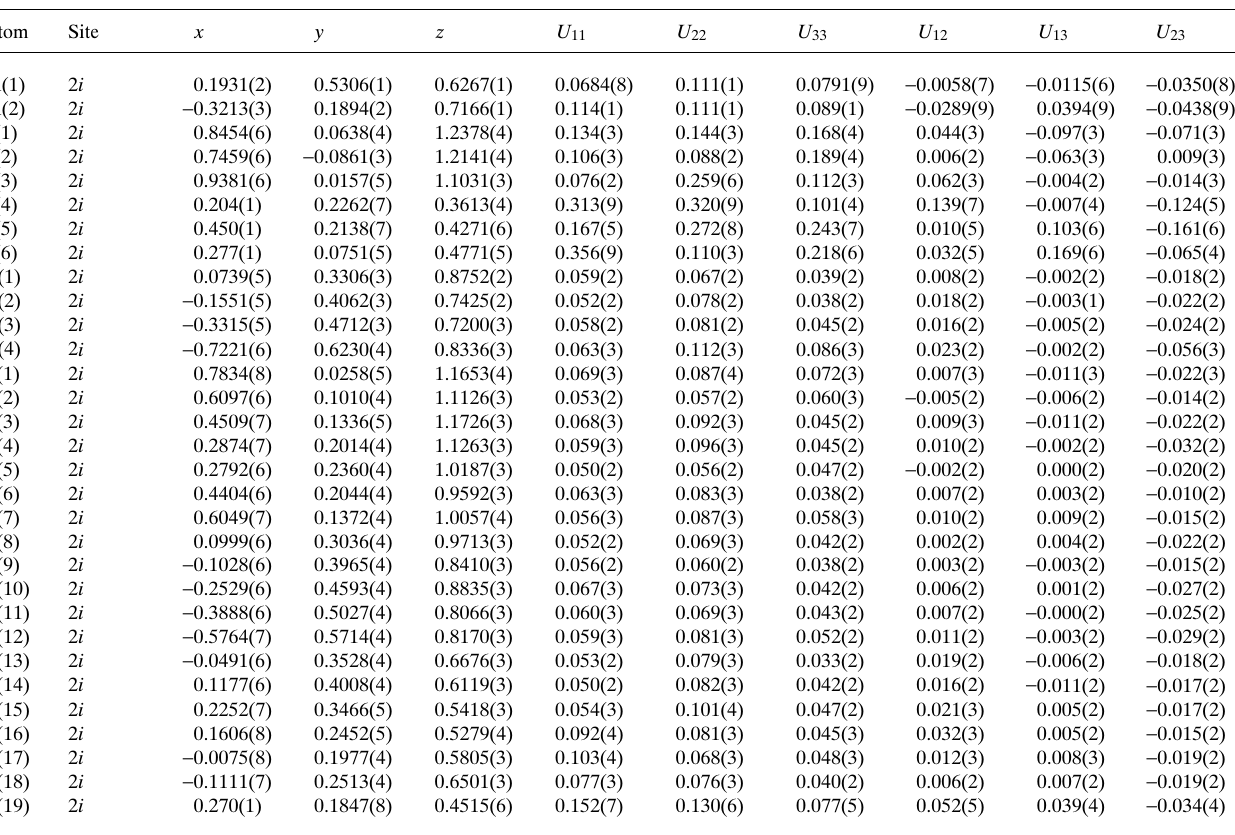
Table 3. Atomic coordinates and displacement parameters (in Å 2 ) .